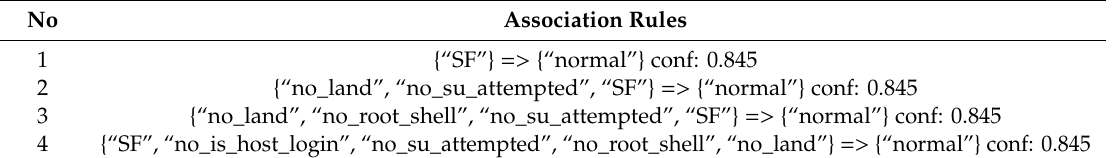
Table 9. Calculated association